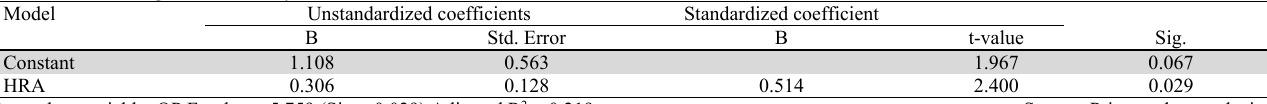
The results of regression analysis Model